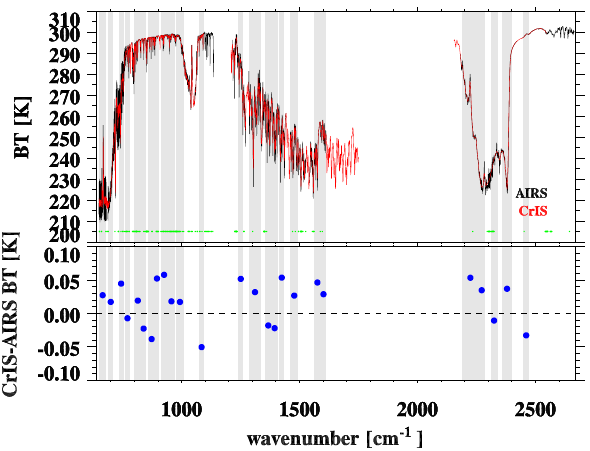
Figure 8. Top: CrIS (black) and AIRS (red) spectra simulated by LBLRTM using an identical atmospheric profile. Bottom: their spectral differences along the 25 spectral regions, indicated by the gray bars. The green dots indicate the AIRS degraded or dead chan-